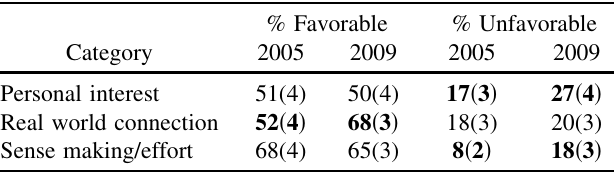
TABLE VII. CLASS categories [1] exhibiting significant shifts over four years. The 2005 data are preinstruction. Significant shifts are shown in